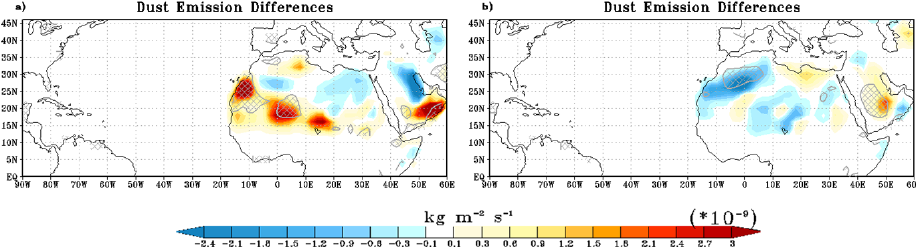
Figure 13. Seasonal mean dust emission differences (Method 3 minus Method 2) for JJA (a) and DJF (b) . Average dust emission in the emitting region is about 1 × 10 − 8 kgm − 2 s − 1 . Hatch marks represent significance at the 90% level using the Student’s t test. Crosshatch marks represent significance at the 95%